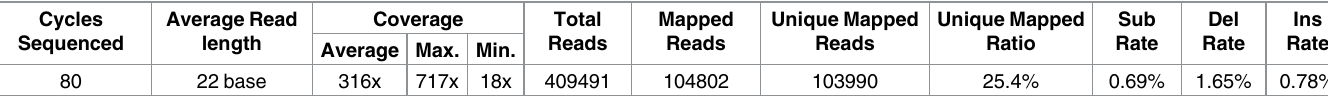
Table 1. M13 genome sequencing statistics. Cycles Sequenced